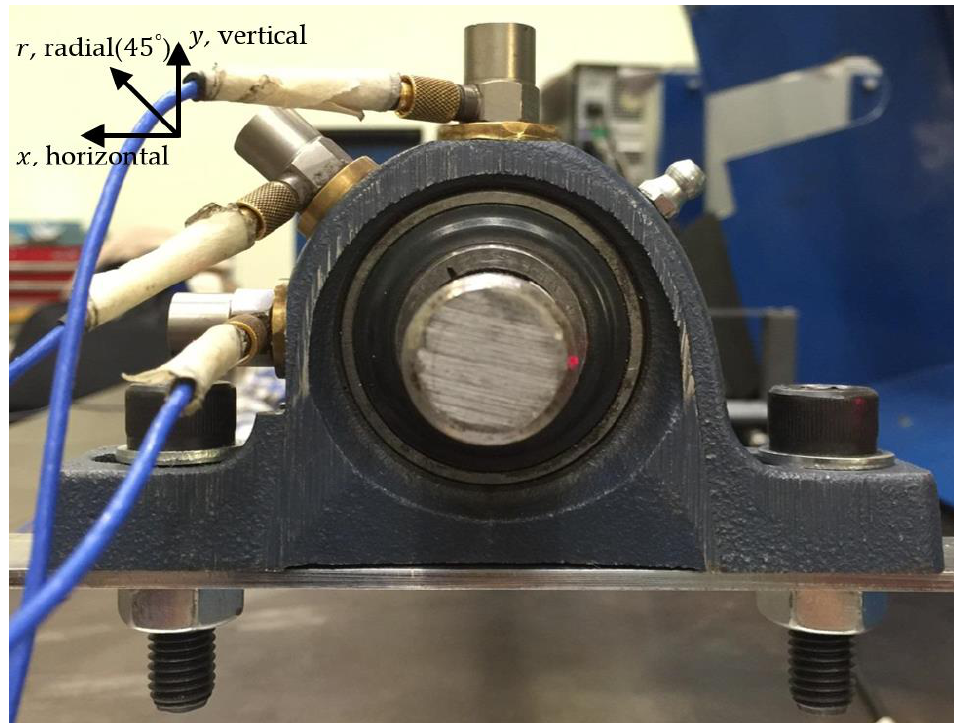
Figure 3. Arrangement of accelerometers on the bearing housing. Machines 2016 , 4 , 19